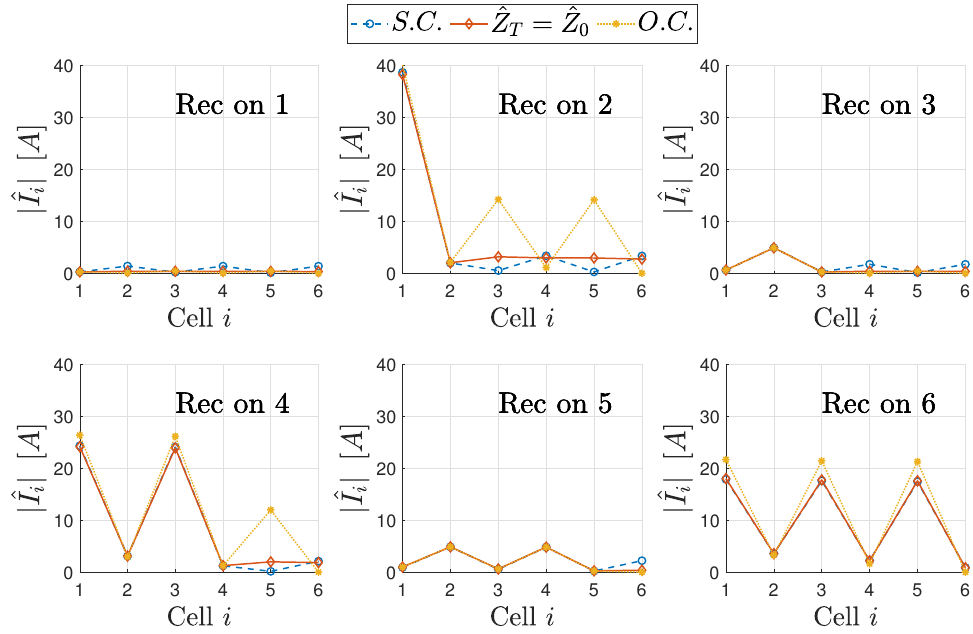
Figure 15. Standing wave patterns for different positions of the receiver, different terminations and a receiver load ˆ Z load = 0.7 Ω